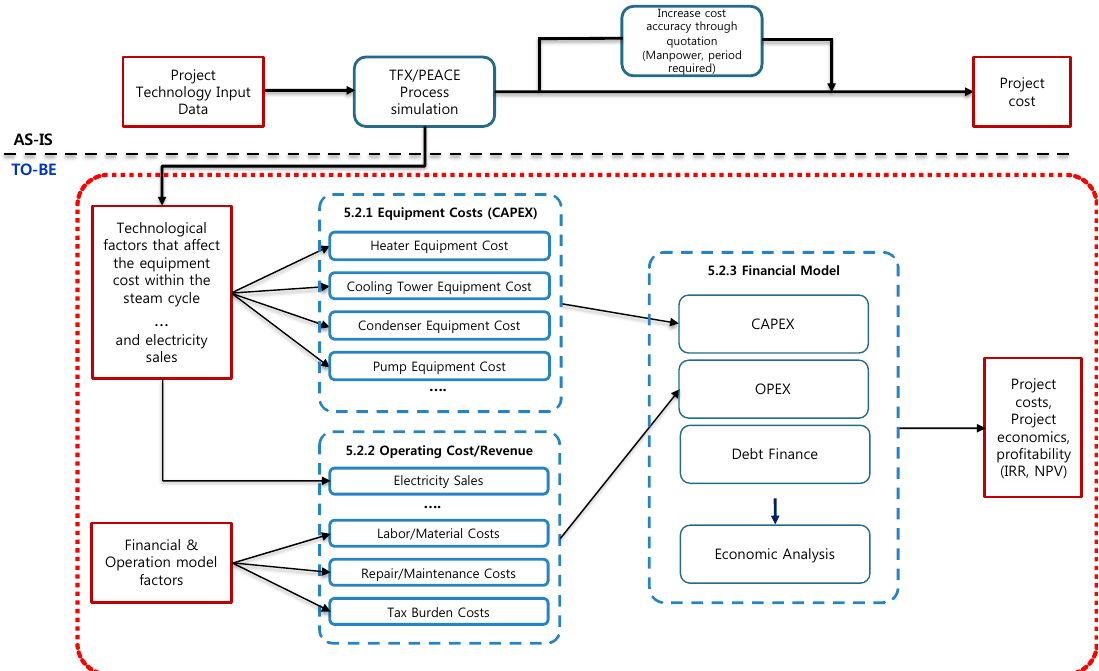
Figure 3. Proposed cost analysis model structure.